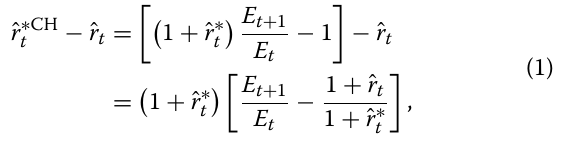
which delivers a clear message: the euro portfolio strongly over-performed in “peacetime" but this was followed, with the advent of the financial crisis, by a reversal in favor of the CHF portfolio, leading to almost exactly 8 years of superiority of the euro portfolio followed by 8 years of